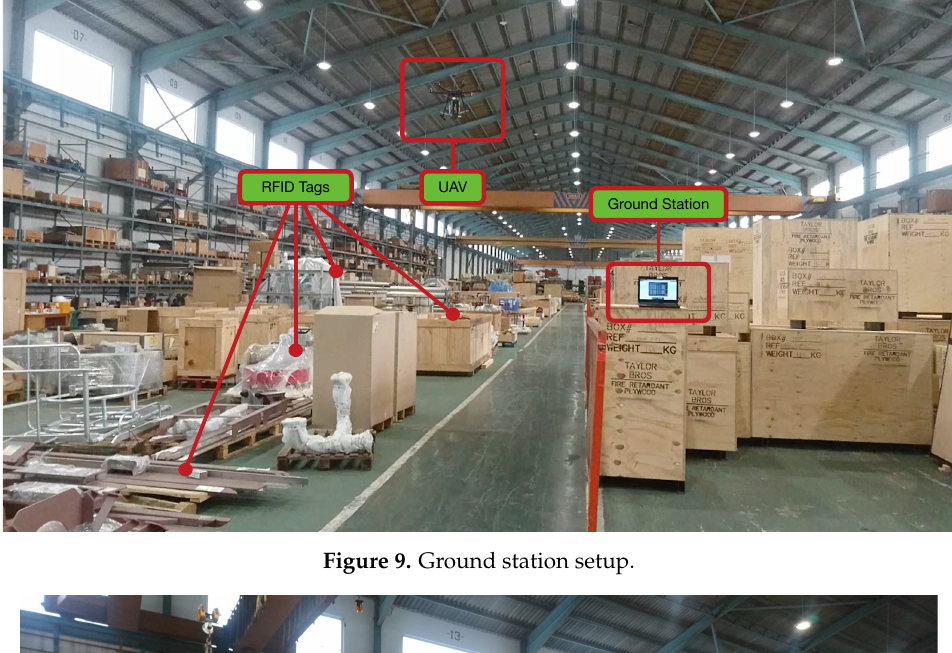
Figure 9. Ground station setup.